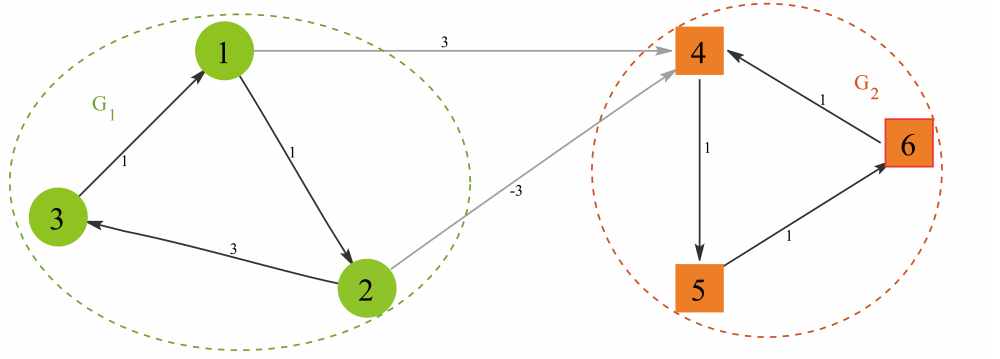
Figure 7. The acyclic partition topology for two groups.